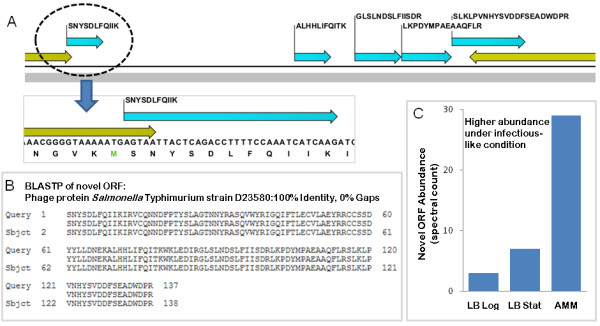
Identification of novel genes. A) Five proteomics identified peptides map to the genomic region 795142 to 795556 on the forward strand, where no gene had been previously predicted by computational approaches. B) Sequence alignment shows 100% homology to a phage protein in Salmonella Typhimurium strain D23580. C) Examination of protein expression shows the novel ORF is highly expressed under infection-mimicking conditions.